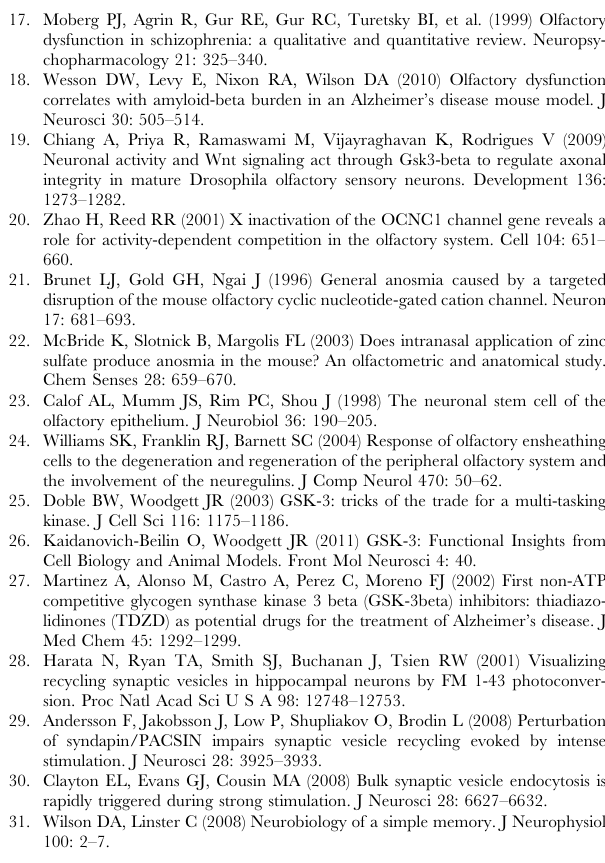
Figure S1 The broad expression of GSK3 b in the adult mouse OB. A: Low magnification view of GSK3 b staining signal in the adult OB. White boxes indicate the different layers of OB shown in B–D at higher magnification. B: The glomerular layer (GL). C: The mitral cell layer (MCL). D: The granule cell layer (GCL). Scale bar: A, 200 m m; B–D, 50 m m. (TIF) Figure S2 The constitutive phosphorylation of Y216- GSK3 b in the adult mouse OB. A: The majority of mitral cells are positive for Y216-GSK3 b (yellow arrow). B: The granule cells (yellow arrow) express Y216-GSK3 b . C: Western blot shows that Y216-GSK3 b is abundantly detected in the adult mouse OB. Scale bar: 50 m m. (TIF) Figure S3 Expression levels of Syn and GAP43 at different ZnSO 4 irrigation stages. Syn and GAP43 expres- sion levels in the OB were all significantly reduced two weeks and one month post ZnSO 4 irrigation (5–6 mice per group, all P , 0.05) and nearly recovered 4 months post-ZnSO 4 irrigation (5 mice, P . 0.05). Syn, Synaptophysin; GAP43, growth associated protein 43; Con, control; 2W, 2 weeks; 1M, 1 month; 4M, 4